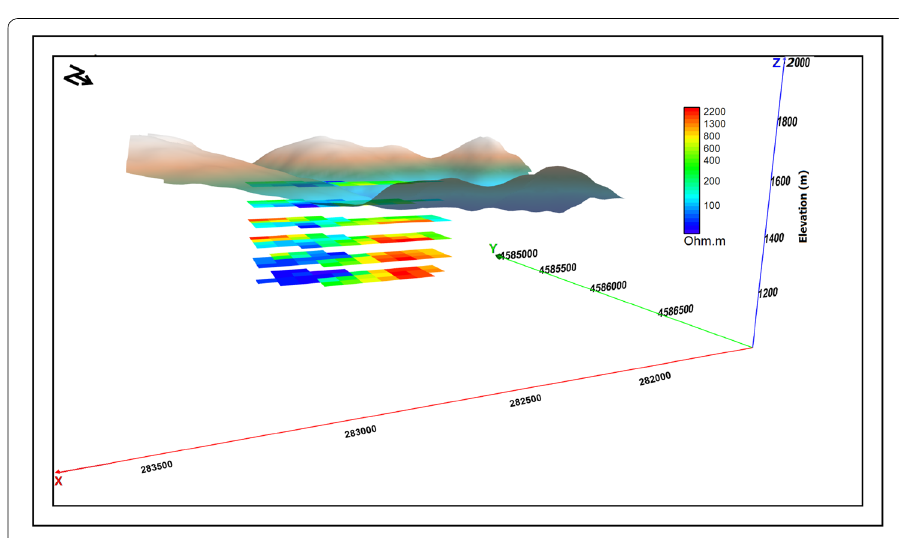
Fig. 6 3D resistivity map obtained from 2D